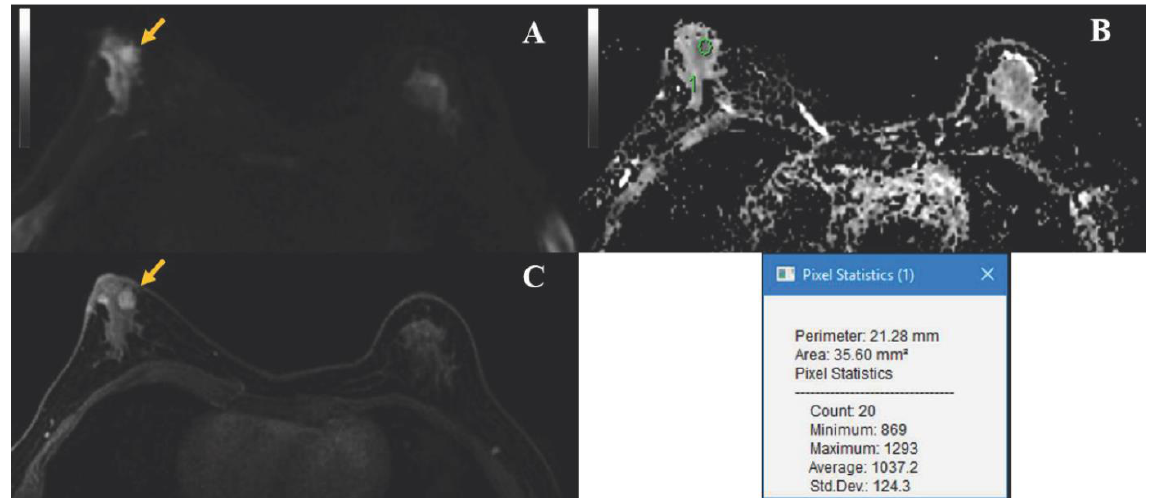
Figure 4. Axial MR images of a 40-year-old woman with a 9 mm benign mass, of which the biopsy yielded intraductal papilloma (yellow arrows). ( A ) Axial diffusion-weighted imaging (DWI) at a b value of 800 s/mm 2 shows a hyperintense lesion in the anterior third of the right breast. ( B ) Correlative parametric apparent diffusion coefficient (ADC) map with a region of interest (ROI) placed within the lesion and ROI information. ADC values are expressed in mm 2 /s. ( C ) Axial Dynamic contrast-enhanced image depicts a slightly irregular, heterogeneous enhancing mass corresponding to the hyperintense lesion on DWI. This lesion had suspicious characteristics on dynamic contrast-enhanced images and low ADC values and was therefore categorized as BI-RADS 4 in a clinical read, subsequently undergoing a biopsy. Multiparametric radiomics accurately classified the lesion as benign.